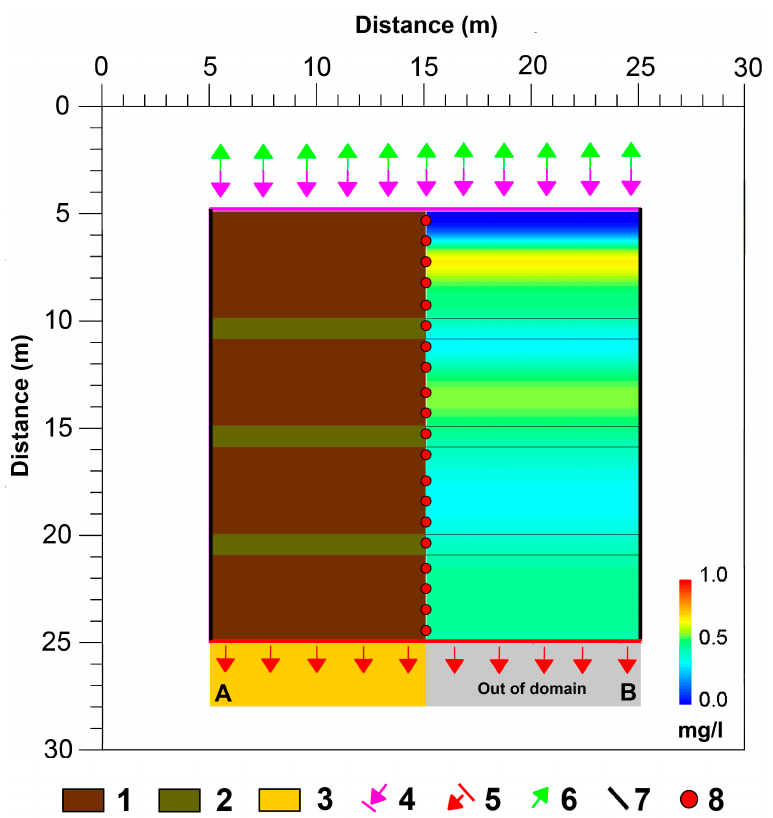
Figure 4. Example of numerical modeling of pollutant propagation throughout the unsaturated zone of a heterogeneous hydro-stratigraphic model, performed by VS2DTI code: (A) heterogeneous hydro-stratigraphic model with three silt intercalated layers; (B) results of pollutant propagation at the end of the 10-year simulation period. Keys to symbols: (1) loamy sand soil; (2) silt intercalated layer; (3) Neapolitan Yellow Tuff (NYT), external to the modeled domain; (4) flux into the domain (infiltration); (5) possible seepage face; (6) outflow from the domain (evapotranspiration); (7) no-flux boundary; and (8) observation point.